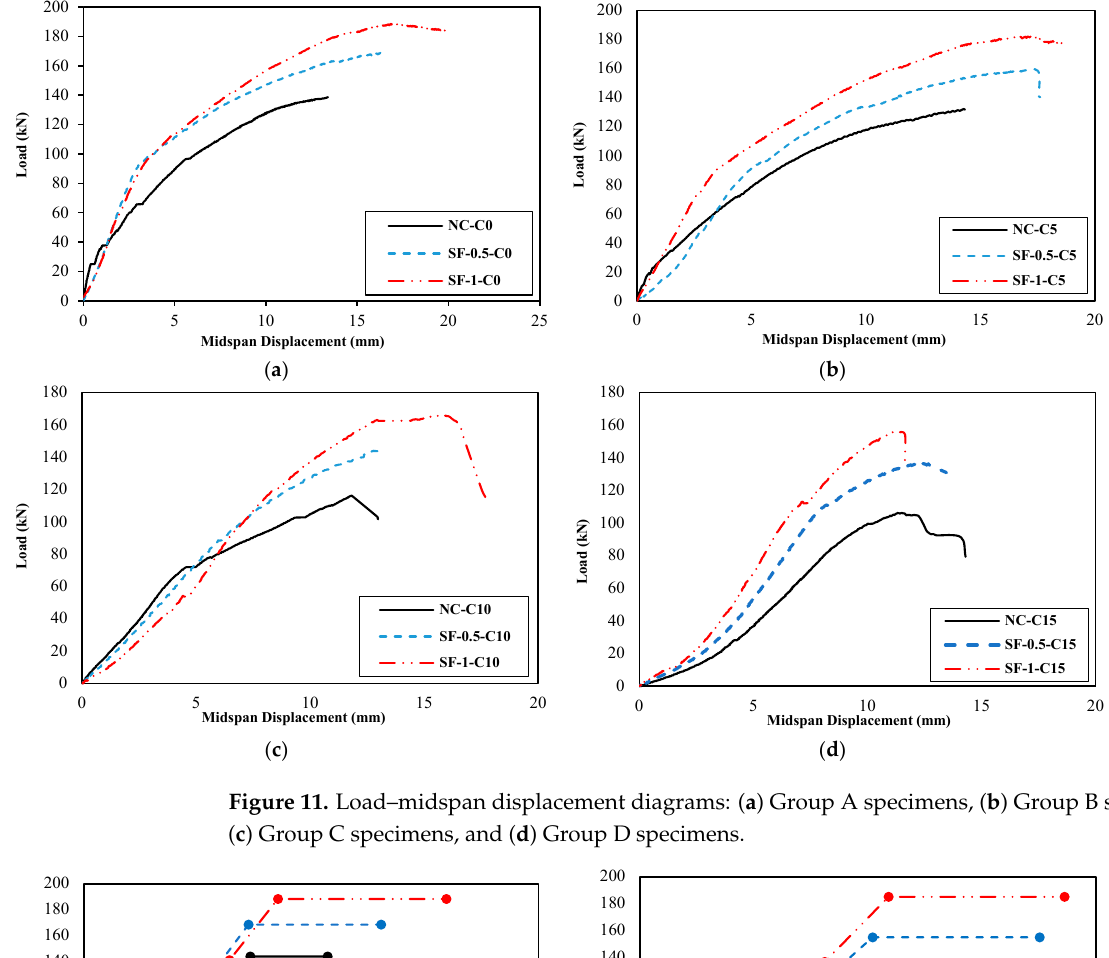
Figure 10. Idealization of the load–displacement curve with an equivalent bilinear diagram. Figure 11 presents the load–midspan displacement diagrams of groups A, B, C, and D, and Figure 12 illustrates their equivalent bilinear diagrams for comparison purposes.